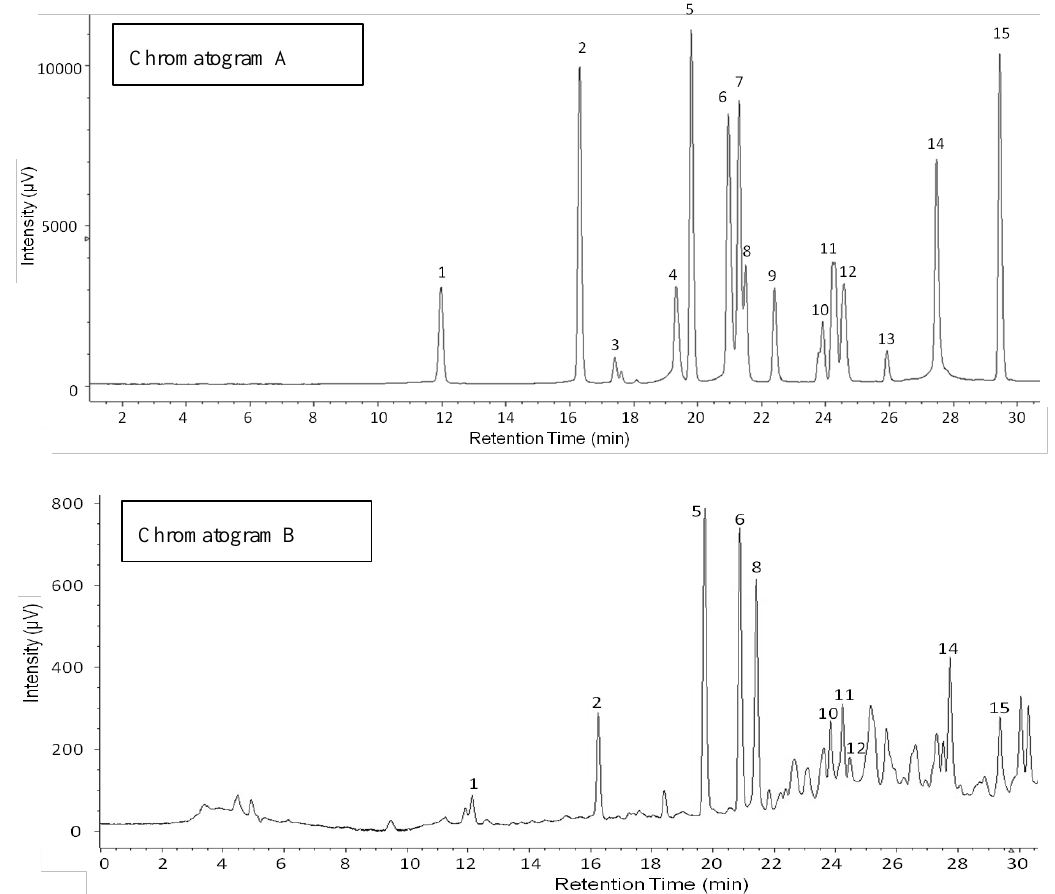
Figure 1. High Performance Liquid Chromatography (HPLC) chromatograms of phenolic standards